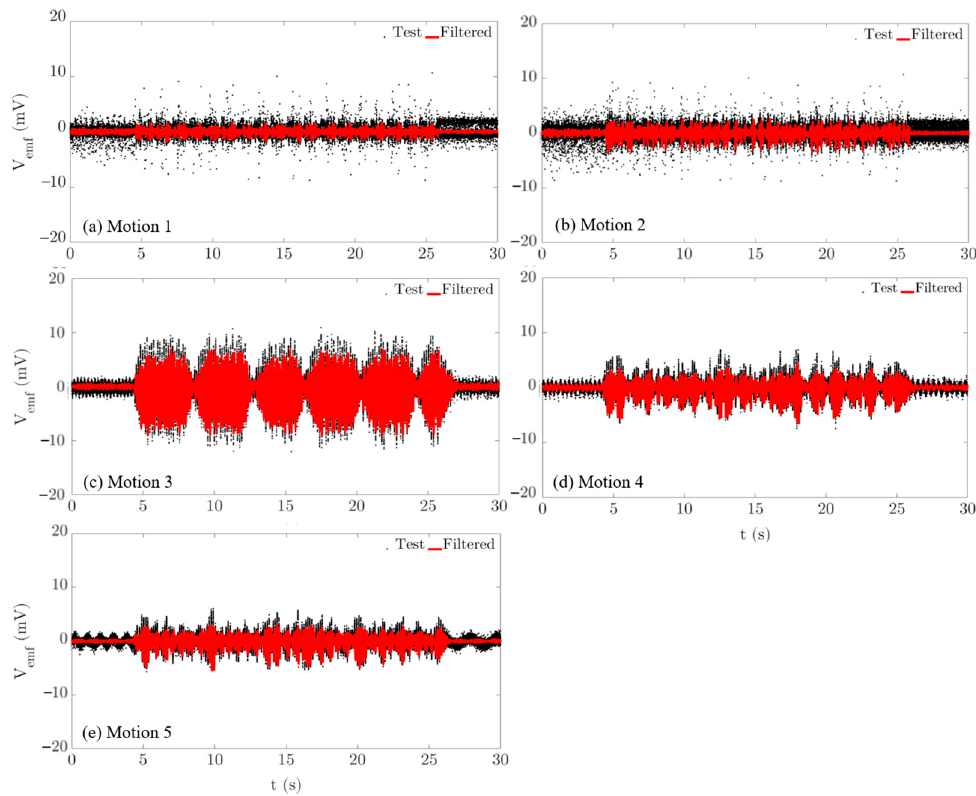
Figure 12. Voltage output from the prototype EMEH subjected to five different base excitations with the frequencies from f b = 1.5 Hz to f b = 3.0 Hz; RMSs of these voltage signals are ( a ) 0.54 mV, ( b ) 0.93 mV, ( c ) 2.9 mV, ( d ) 1.6 mV, and ( e ) 1.3 mV.